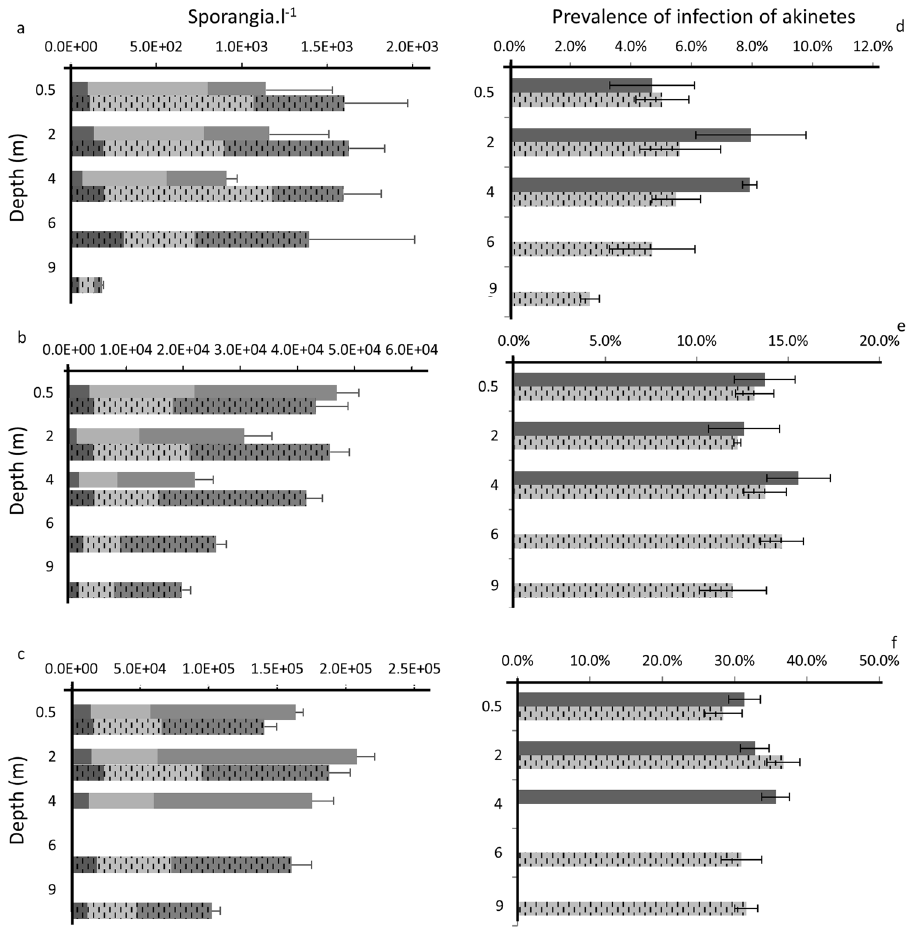
Figure 2. Distribution of R. akinetum . Vertical and horizontal distributions of the life phase abundance of R. akinetum (left column: Young phase (grey), Mature phase (light grey), Empty phase (dark grey)) and Prevalence of infection of akinetes (right column) on the 7 th ( a , d ), 14 th ( b , e ) and the 21 st of October 2011 ( c , f ) at Central (hatched bars) and Littoral (solid bars) stations. Error bars represent the standard deviation for three replicates.